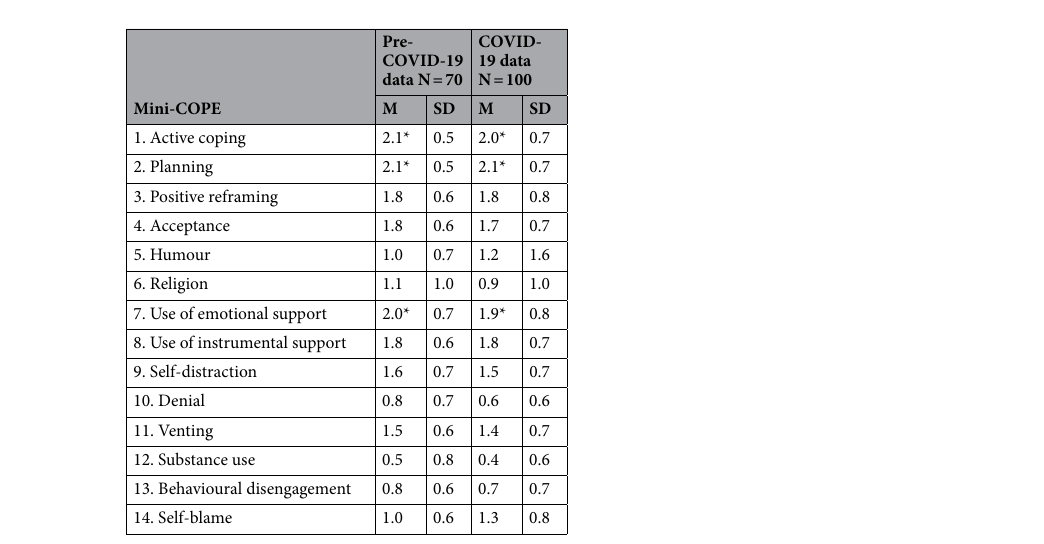
Table 6. Mini-COPE results prior to and during the COVID-19 pandemic. Mini-COPE – the Brief Coping Orientation to Problems Experienced inventory. *The most commonly employed